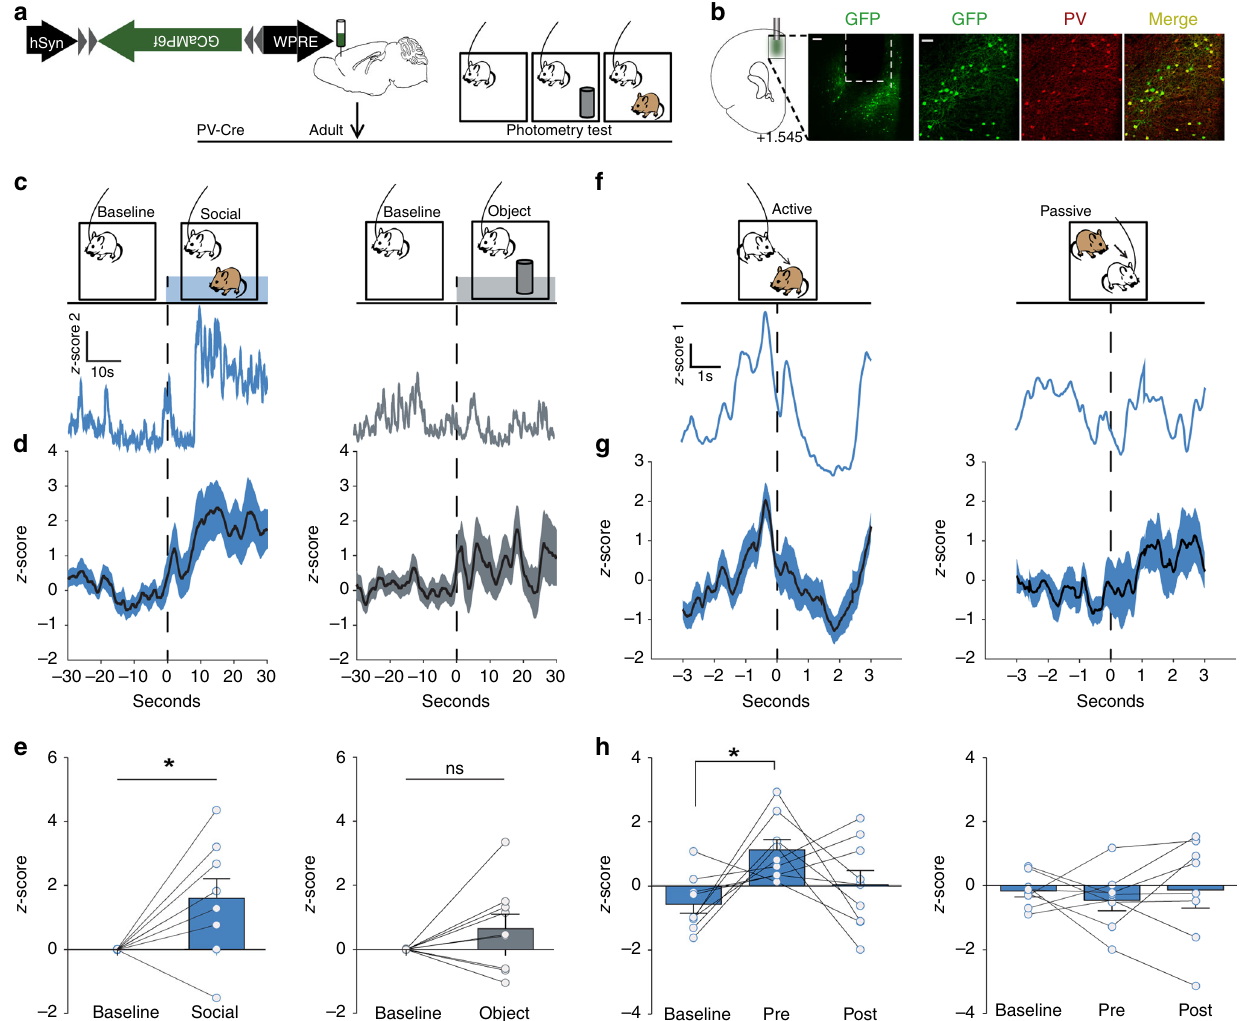
Fig. 1 Short activation of dmPFC PVIs precedes an active social approach. a Timeline showing injection of GCaMP6f in adult dmPFC in PV-Cre mice and subsequent behavioral testing paradigm for fi ber photometry imaging (order of object and social exploration was counterbalanced). b Example location of fi ber ferrule and GCaMP6f expression in mouse PFC (left) and co-localization of GCaMP6f expression (green) and PV staining (red). (left, scale bar = 100 μ m; right, scale bar = 50 μ m). c , d GCaMP6f signals of dmPFC-PVIs show increased mean z -score 30 s after introduction of a novel mouse (left), but not a novel object (right). c Example GCaMP signal traces. d Mean + / − SEM smoothed signal. e Mean dmPFC-PVI GCaMP6f signal for each mouse comparing baseline and post stimulus introduction for social and object (Wilcoxon signed-rank test, n = 9 mice, social: * p = 0.03, object: p = 0.25). f Top: active behavior, de fi ned as behavior initiated by the focal mouse (left) and passive behavior, de fi ned as behavior initiated by the stimulus mouse (right) were scored during photometry imaging. Bottom: Representative responses from the fi rst active and fi rst passive bout shows an increase in dmPFC-PVI activity immediately prior to the active bout initiation. No change is seen in the passive bout. g Mean + / − SEM smoothed signal for the fi rst active and passive bout. h Mean dmPFC-PVI GCaMP6f signal for each mouse comparing baseline ( − 3 to − 2 s before active/passive initiation) pre ( − 1 to 0 s)